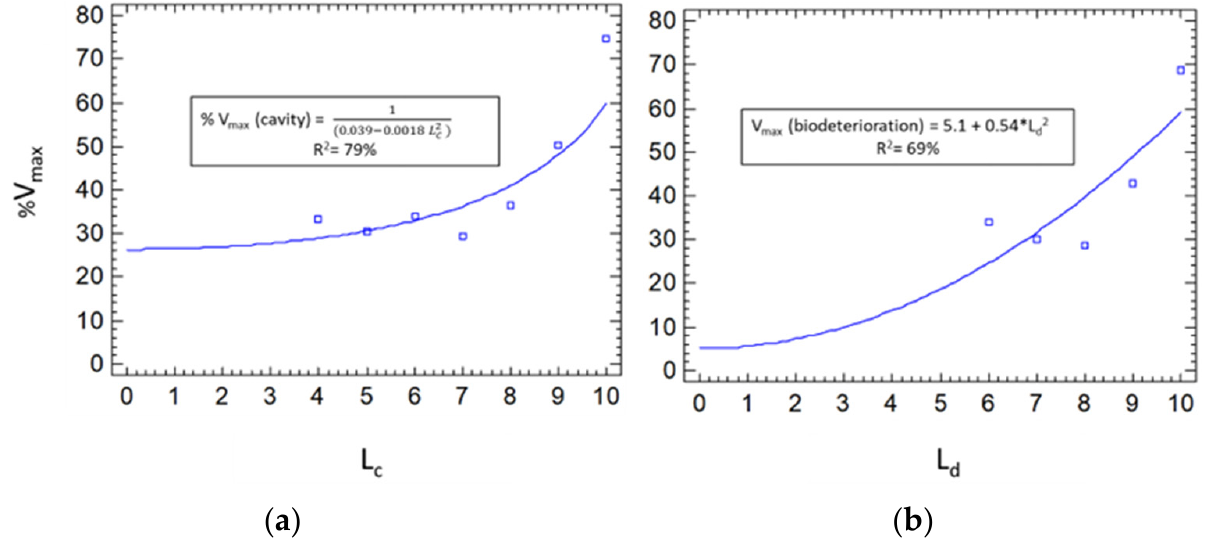
Figure 8. Behavior of the average percentage of the maximum velocity as a function of the percentage interval of the path length within the zones with cavity ( a ) represented by Reciprocal-Y Squared-X model and biodeterioration ( b ) represented by a Squared-X model. Legend: Lc (percentage of the path length within the zones with cavity) or Ld (percentage of the path length within the zones with biodeterioration) = 100% of the interval = 0; Lc or Ld between 91% and 100% of the interval = 1; Lc or Ld between 80% and 90% of the interval = 2; Lc or Ld between 70% and 80% of the interval = 3; Lc or Ld between 60% and 70% of the interval = 4; Lc or Ld between 50% and 60% of the interval = 5; Lc or Ld between 40% and 50% of the interval = 6; Lc or Ld between 30% and 40% of the interval = 7; Lc or Ld between 20% and 30% of the interval = 8; Lc or Ld between 10% and 20% of the interval = 9; and Lc or Ld < 10% of the interval =